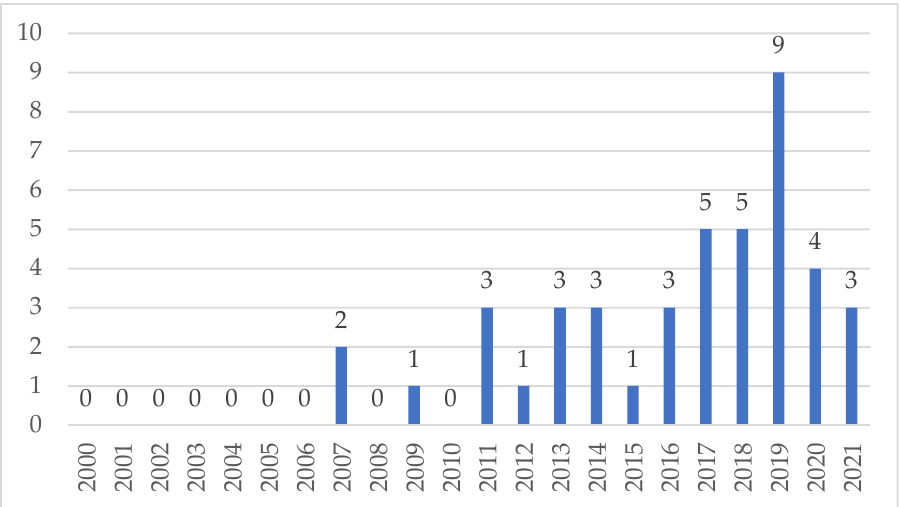
Figure 2. Distribution of articles by year ( n = 43).